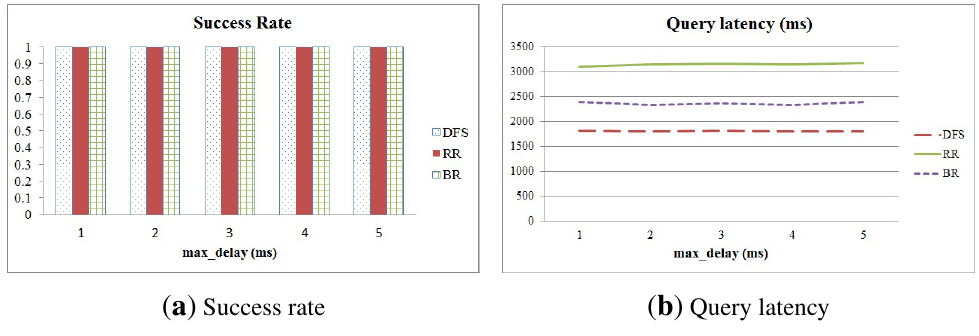
Figure 11. Success rate and query latency in relation to various delay